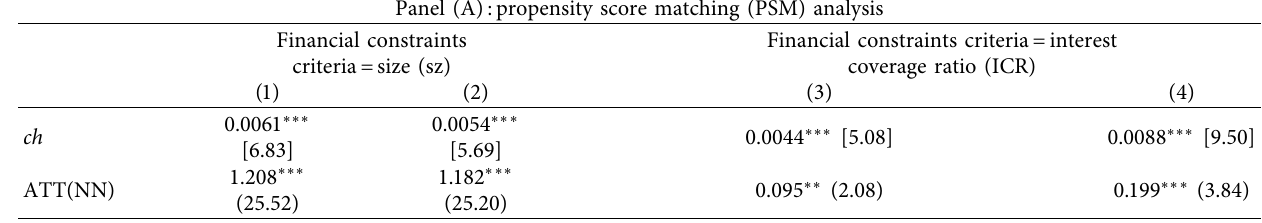
Table 8: Propensity score matching (PSM) and difference-in-difference (DID) estimation